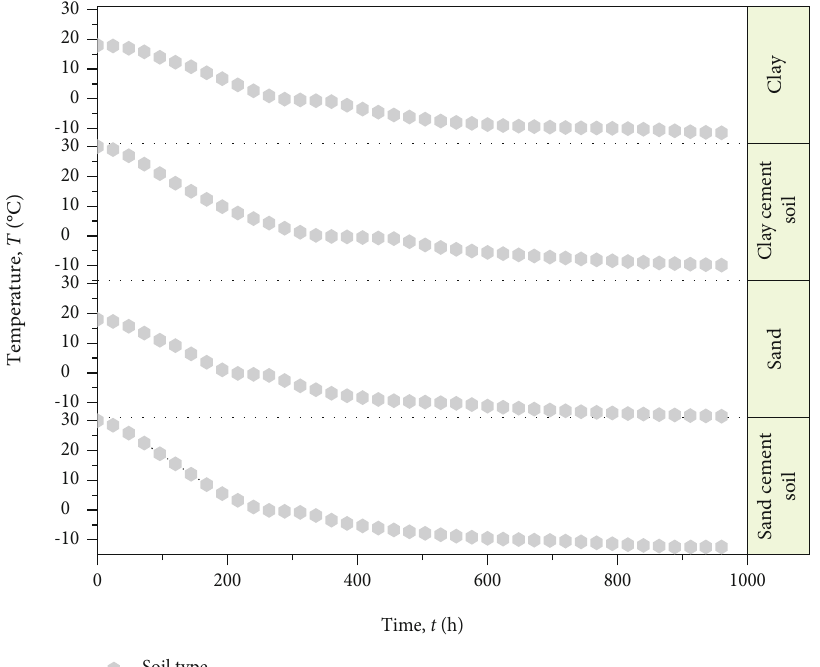
Figure 10: E ff ect of soil type on temperature fi eld development.